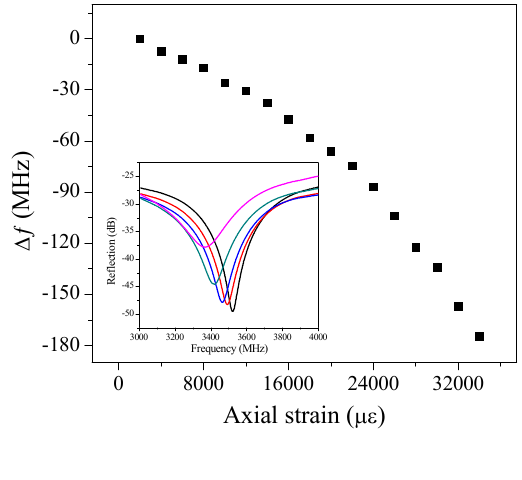
Figure 6. Resonant frequency shift as a function of strain. Inset: Shift in reflection spectra as strain